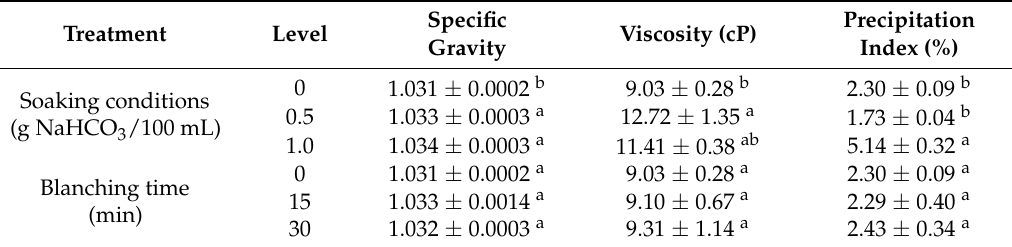
Table 2. Physical properties of millet milk influenced by production variables.